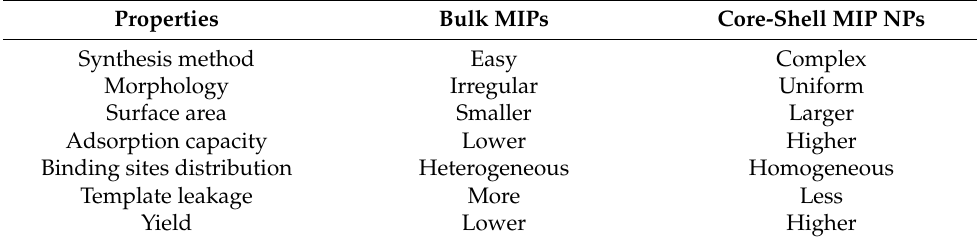
Table 1. Comparison of bulk MIPs and core-shell MIP